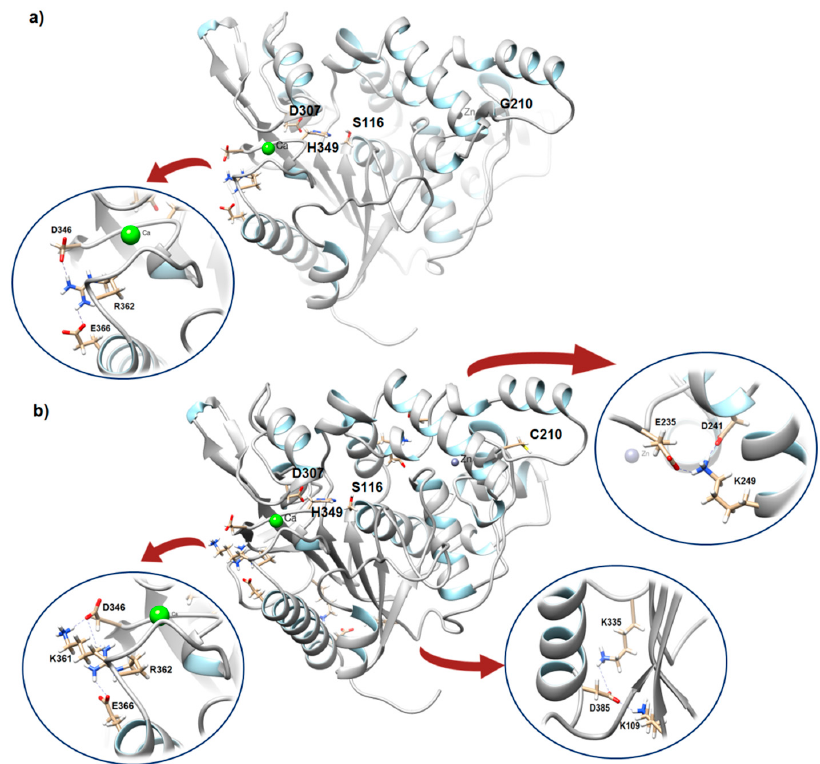
Figure 3. Salt bridge/Ion pair network of rT-M386 and mutant G210C. The catalytic triad residues are labeled as S116, D307 and H349. The salt bridge networks are represented in circle. Contacts formed between residues ( a ) in rT-M386: R362-K361/R263-D346 and ( b ) in G210C: R362-E366/R362-D346, K109-D385/K335-D385 and K249-E325/ K249-D241.